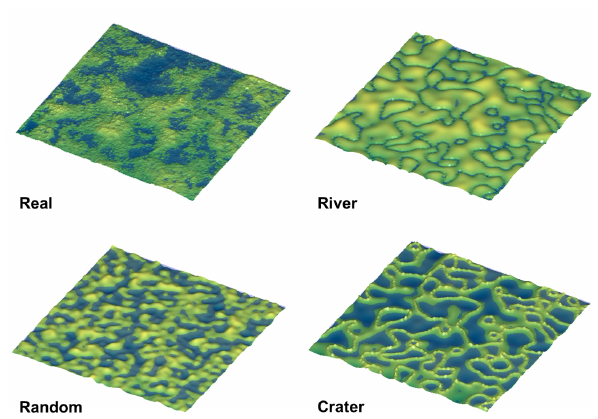
Fig. 1. Detail of the four microtopography types (2m × 2m) with depressions partially filled with water (in blue) in order to highlight the contrasting connectivities.